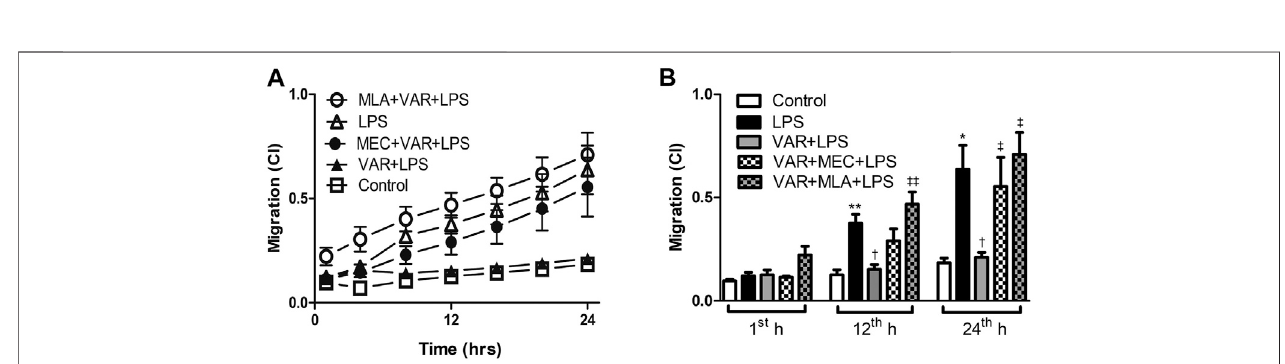
FIGURE 6 | Effects of varenicline on LPS-induced cell migration in the presence or absence of nAChR antagonists. Shown are line graphs drawn by the averaged datapointsofreal-timemigrationassaytracings (A) andthecumulativedata (B) .RAW264.7cellsweretreatedwithvarenicline(VAR,1 μ M)inthepresenceorabsenceof mecamylamine (MEC, 50 μ M) and methyllycaconitine (MLA, 1 μ M) prior to lipopolysaccharide (LPS, 4 μ g/ml) administration at the 24th hour. Then, cell migration rates were monitored for 24 h after the treatments. Data are expressed as mean ± S.E.M. (* p < 0.05; ** p < 0.01 vs. the control group; † p < 0.05 vs. the LPS group; ‡ p < 0.05, ‡‡ p < 0.01 vs. LPS + VAR group, n (cid:1) 5 – 7, One-way ANOVA with post hoc Tukey – Kramer multiple comparisons test or Student ’ s t -test).